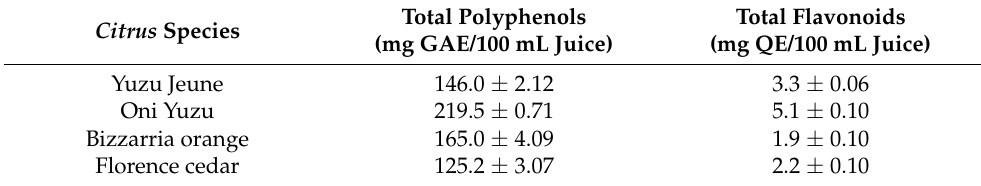
Table 2. Polyphenols and flavonoids of citrus juices.